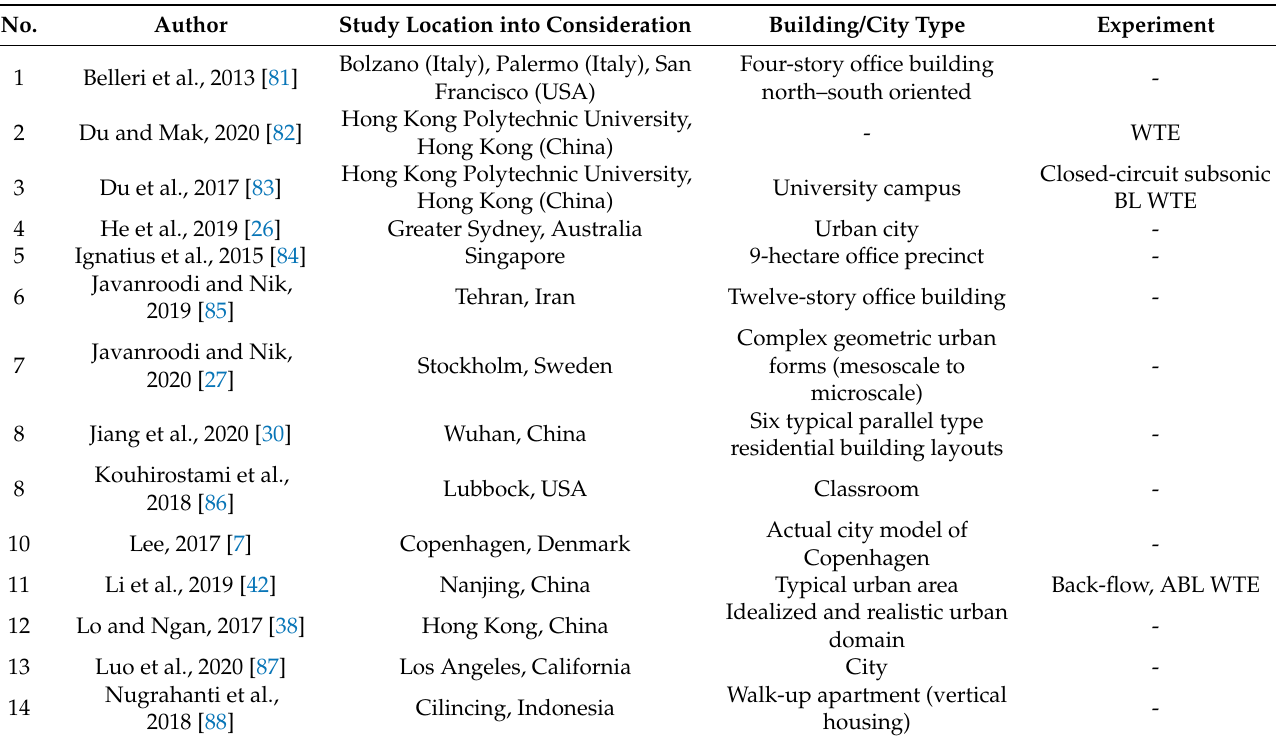
Table 8. Overview of studies of real urban areas with validation comparison with experimental or numerical data: name and type of studied location and type of